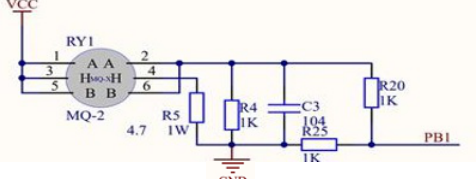
Fig. 4 . The circuit diagram of MQ-2